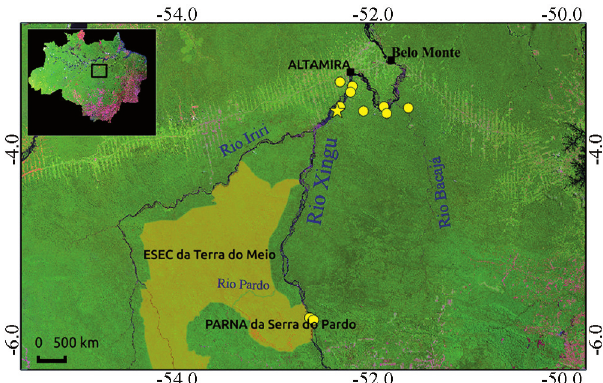
Fig. 4. Map of Northern Brazil and part of rio Xingu drainage showing collecting sites of Crenicichla anamiri . Some dots may represent more than one lot (star = holotype).